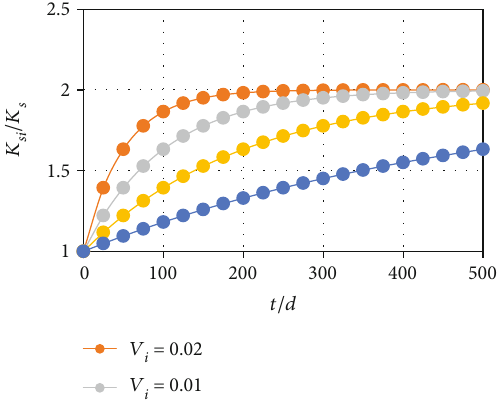
V s and i in polluted area at